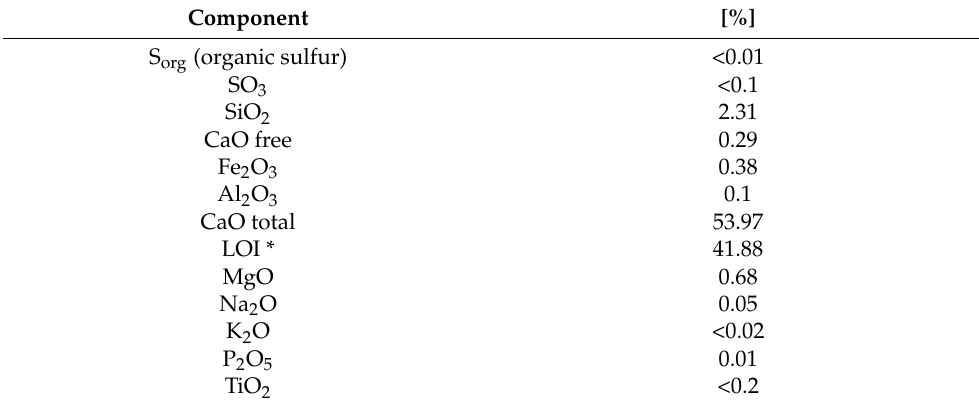
Table 3. Chemical composition of the sorbent used in the tests,